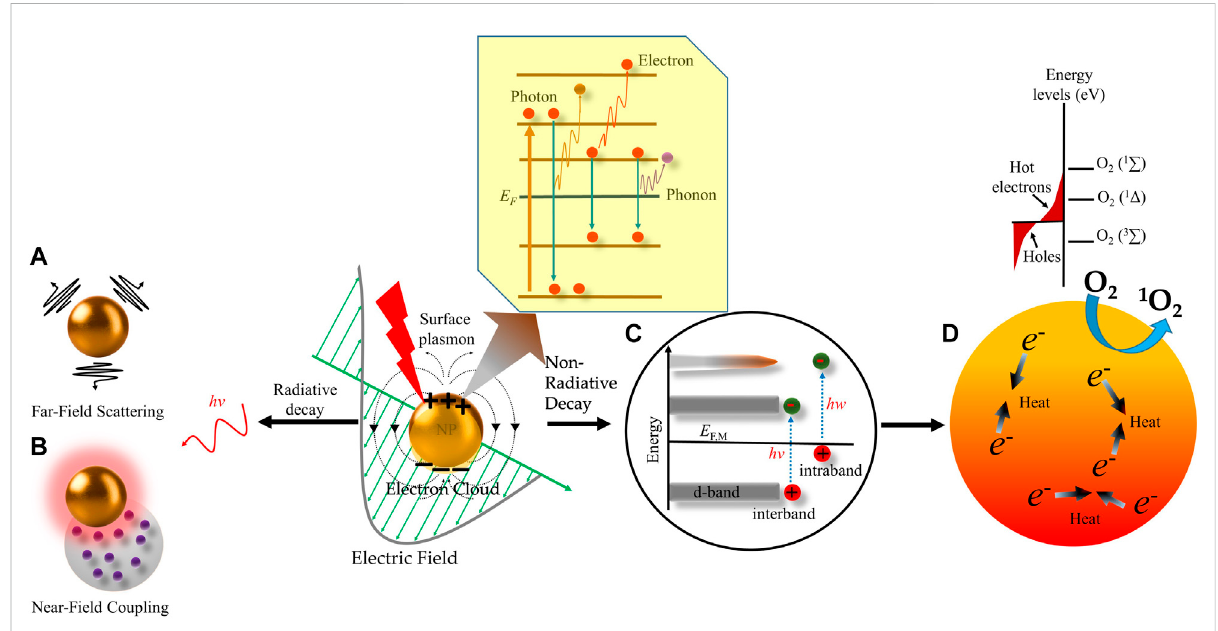
FIGURE 4 Schematic representation of radiative and non-radiative decay of plasmons in metal nanoparticles. Excitation of plasmonic nanoparticles (NP) generates localized surface plasmon resonance (LSPR). Surface plasmon decays in three different ways, i.e., electron-to-photon, electron- toelectron, and electron-to-phonon (subset). The radiative decay process either gives rise to (A) light scattering into the nanostructures ’ “ far- fi eld. ” i.e.,aregionthatisfarfromtheelectromagnetic fi eld,or (B) electromagnetic fi eldsinthenanostructures ’“ near fi eld ” ,i.e.,aregionthatpossesses inductive effect. The nonradiative decay proceeds through (C) intraband excitation within the conduction band of the metal or an interband excitationbetweenoccupiedbands(usually dbands)andtheconductionband. Thisresultsinthegenerationof (D) non-thermaland “ Hotelectrons ” which have high energies to excite molecular oxygen (O 2 ) to its excited state to generate singlet oxygen ( 1 O 2 ). The scattering of Hot electrons and phonons within the NP increases its temperature by transferring their excitation energy to the NP lattice, which is further transferred to the surroundings by heat conduction and ultimately generates local heating